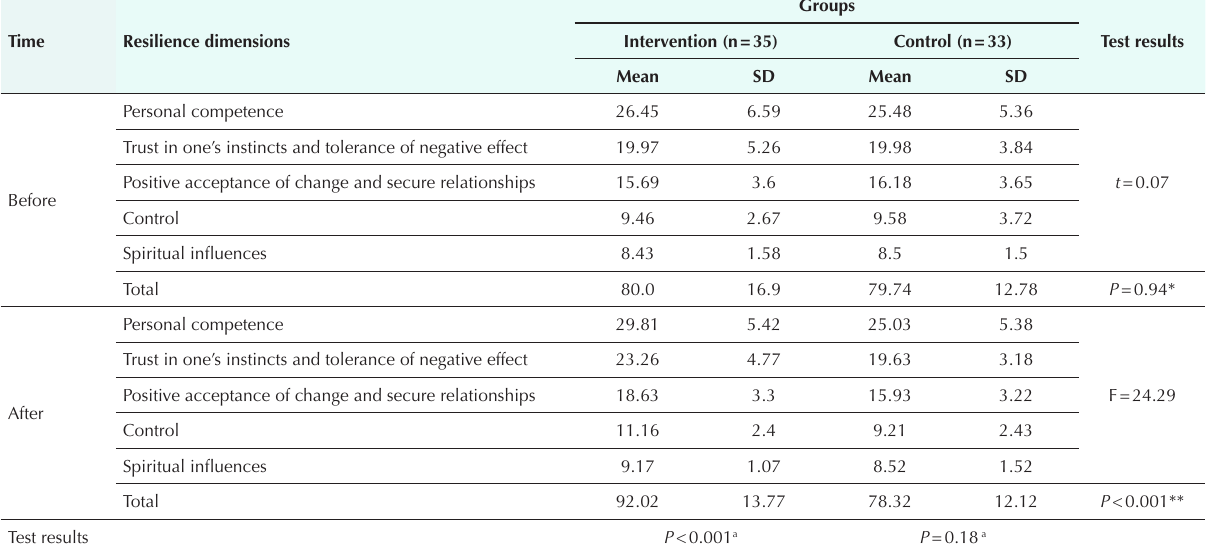
Table 3. Between- and within-group comparisons respecting mothers’ mean scores of resilience and its dimensions